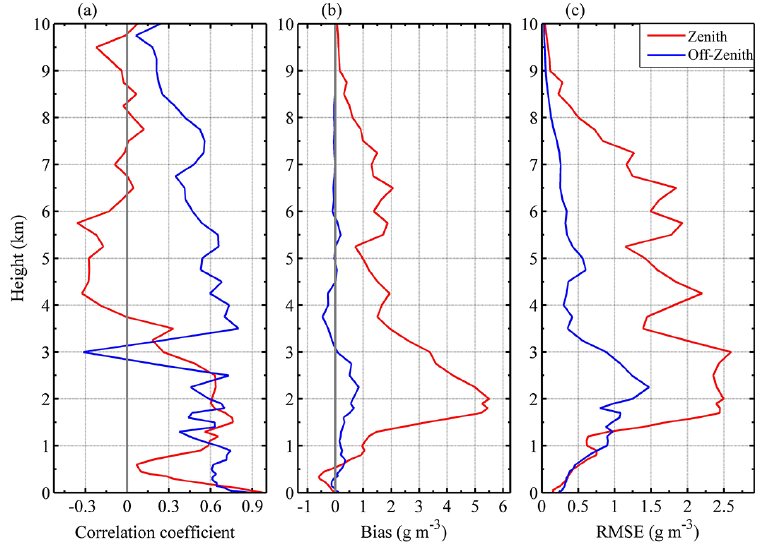
Figure 4. Same as Fig. 2 but for vapor density